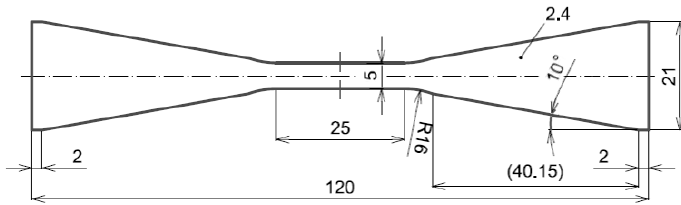
Figure 1. Dimensions (in mm) and shape of the flat dog-bone specimen for fatigue testing.